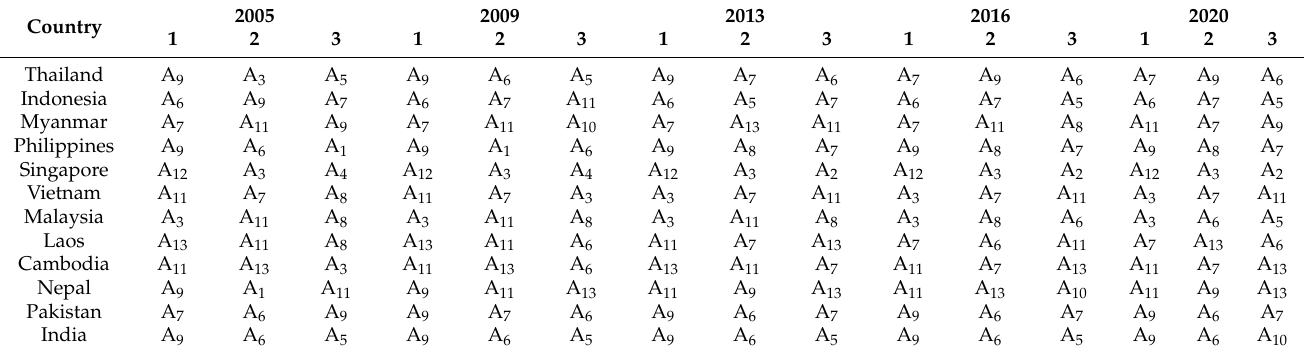
Table 3. Major geopolitical risk obstacle factors of countries along the Belt and